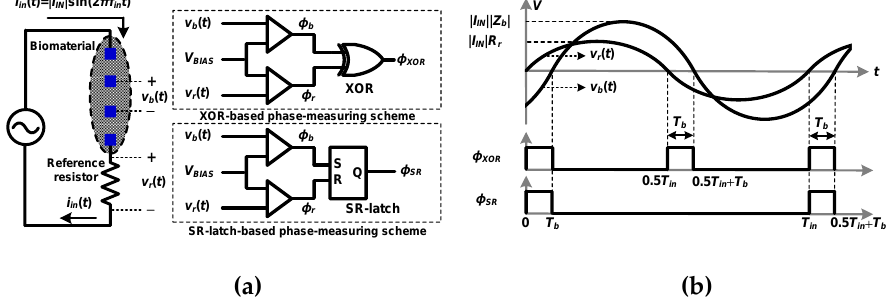
Figure 2. ( a ) Block diagram and ( b ) waveforms of the phase measurement scheme (reproduced Figure 2. (a) Block diagram and (b) waveforms of the phase measurement scheme (reproduced from from [19] with permission from the IEEE). [19] with permission from the IEEE).